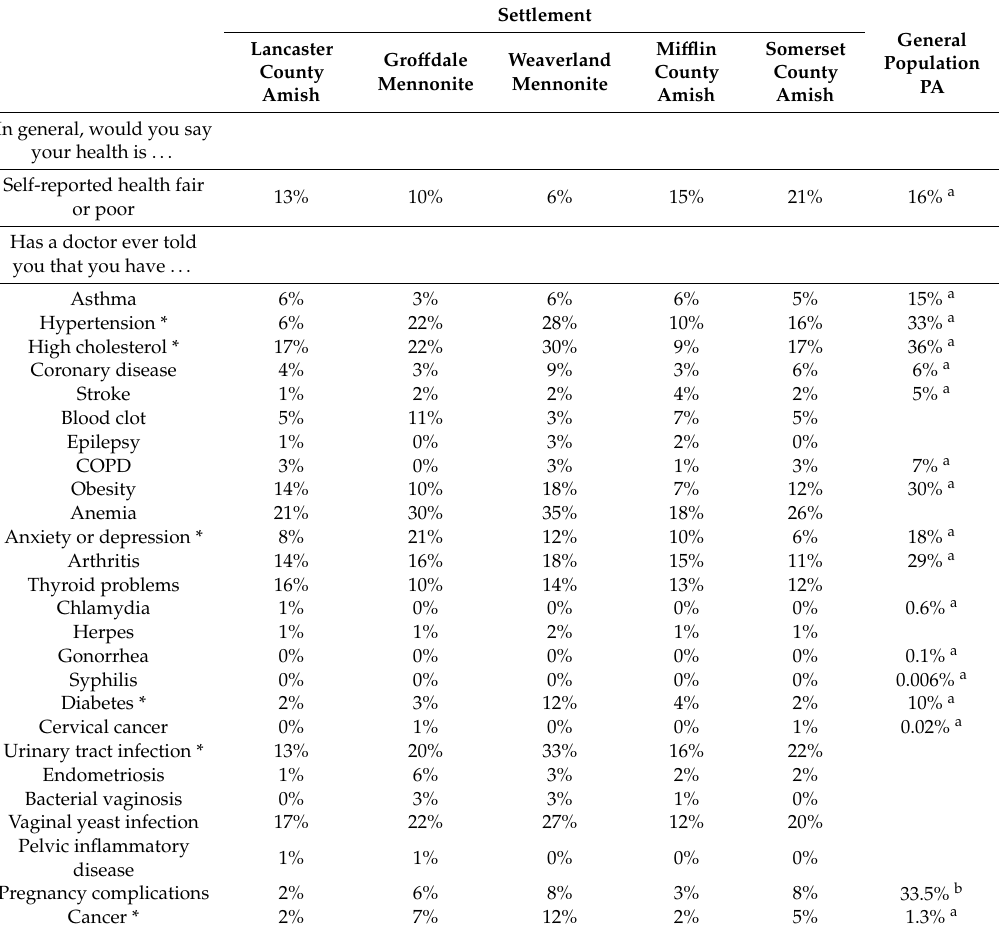
Table 4. Health and health conditions of 5 Pennsylvania Plain communities and the general. Pennsylvania population.